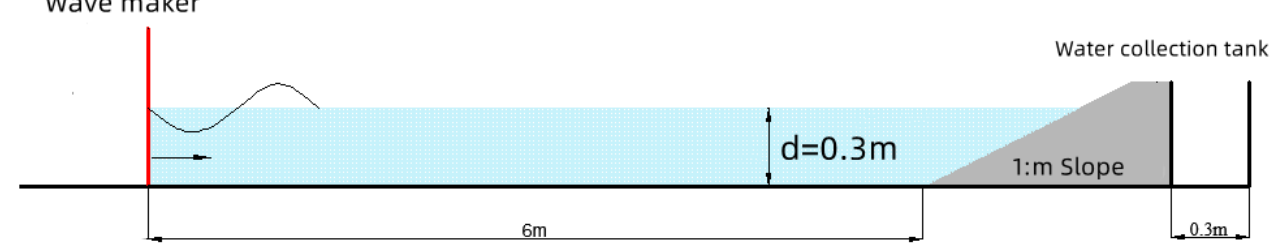
Figure 4. Layout of the numerical wave flume for wave run-up and overtopping, with slope m = 1.5, 2 and 2.5. TB-CUBE armor units were installed on the slope (not shown).